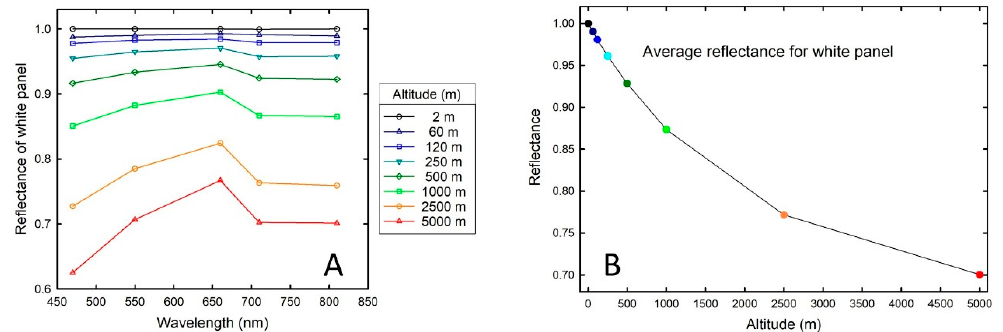
Figure 5. ( A ) Simulated spectra of a white panel on the ground with a sensor / ILS at various altitudes above mean sea level using the MODTRAN 6 model. ( B ) Average reflectance of the white panel from the sensor / ILS at various